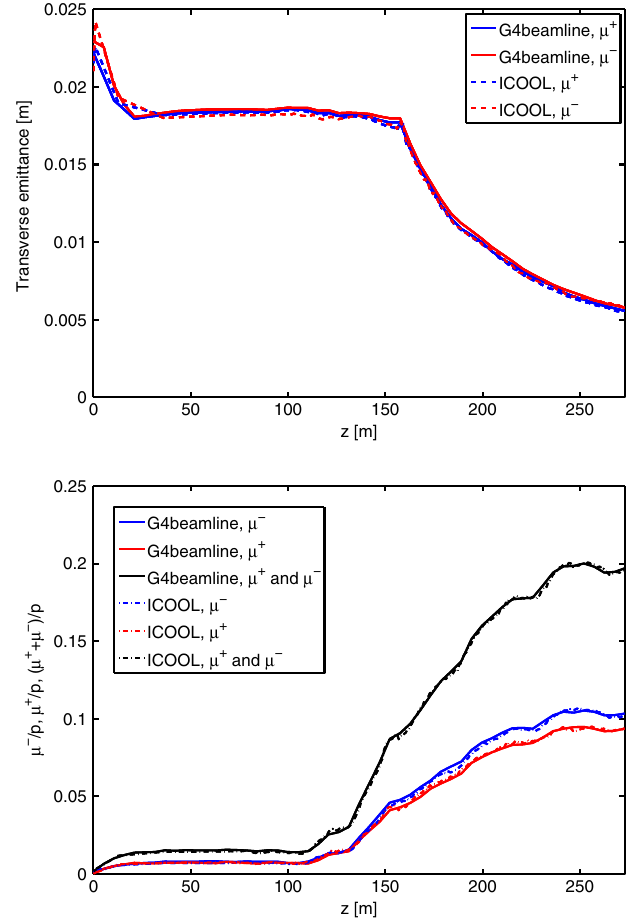
FIG. 4. Performance of the bunching and cooling channel as a function of distance along the channel, as simulated using the ICOOL 3.20 [7] and G4BEAMLINE 2.06 [6]. (top) The evolution of the rms transverse emittance (computed over all bunches). (bottom) The evolution of the number of muons within a reference acceptance (muons within 201.25 MHz rf bunches